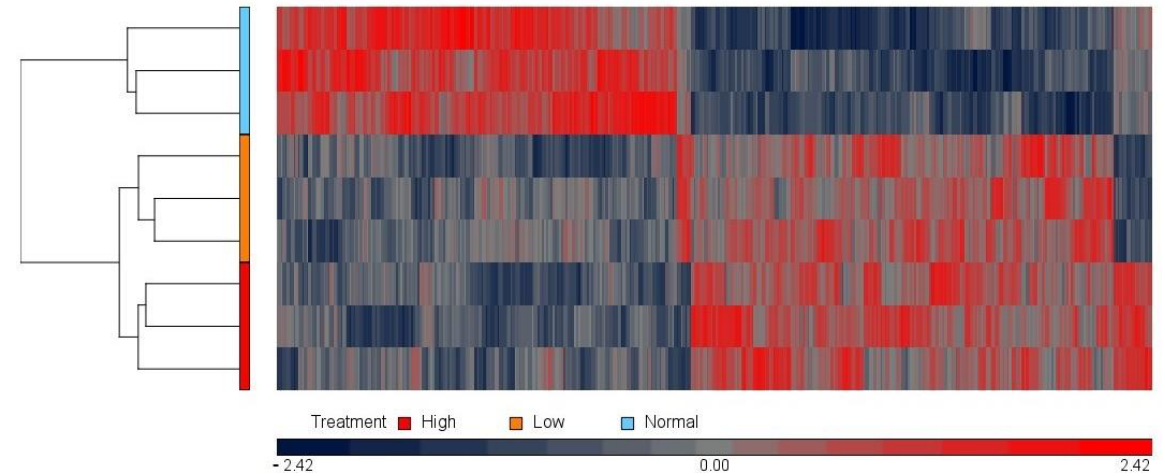
Figure 2. Hierarchical clustering of the 615 genes that were commonly expressed in high- and low- magnesium treatments, with blue blocks representing down-regulated expression and red blocks representing upregulated expression. Each row represents one sample, and each column represents one gene. The red bar on the side of the heat map represents the 5 mM MgSO 4 group, n = 3. The blue bar represents the 1 mM MgSO 4 group (control), n = 3. The orange bar represents the 0.1 mM MgSO 4 group. The scale at the bottom of the diagram represents Log2 fold-change values. Table 3. GO enrichment analysis of transcripts regulated by high magnesium concentration. Analysis applied FDR p < 0.005 for enrichment p